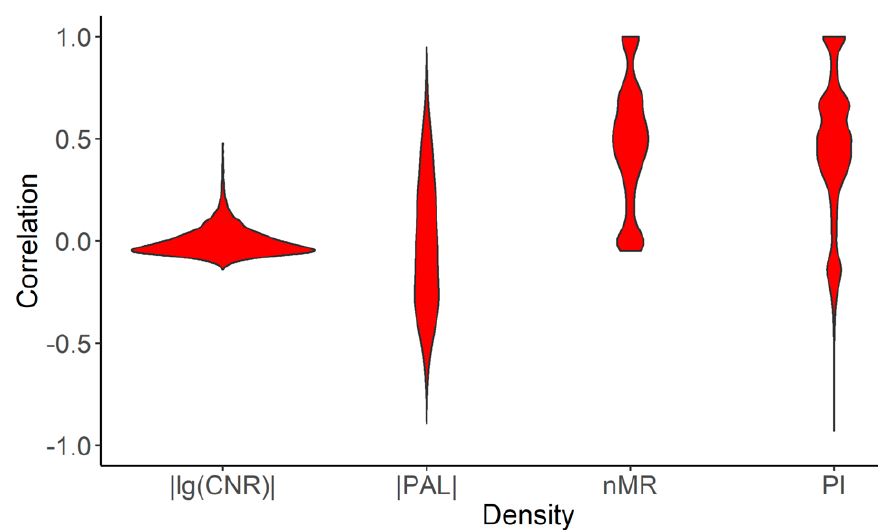
Figure 12. Distribution of correlation coefficients calculated for 4382 tumor samples for ten signaling pathways from [22] and enclosed individual genes between: ( i ) binary alteration score (BAS) at the gene level with absolute values of lg(CNR) and normalized mutation rate (nMR); ( ii ) BAS at the pathway level and absolute values of pathway activation level (PAL) and pathway instability (PI).